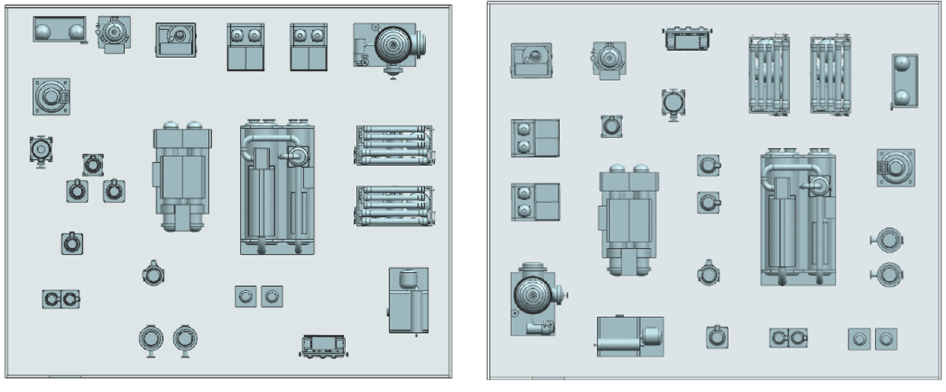
Figure 6. 3D model before and after layout optimization.